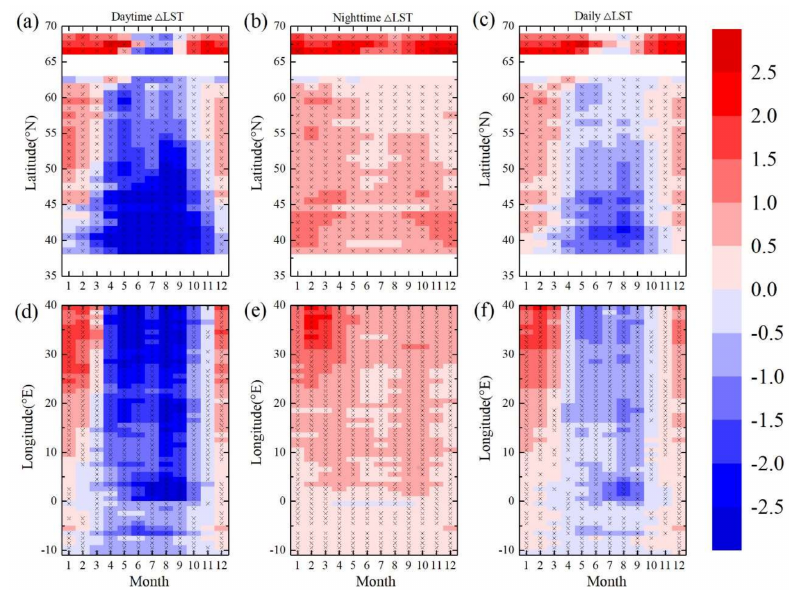
Figure 4. Spatiotemporal patterns of latitudinal variations in ( a ) daytime, ( b ) nighttime, ( c ) daily LST differences (forest minus open land) and longitudinal variations in ( d ) daytime, ( e ) nighttime and ( f ) daily LST differences (forest minus open land) during the period 2003–2016. Grids with cross symbols indicate that the LST differences are significant at the 95% CI by the t